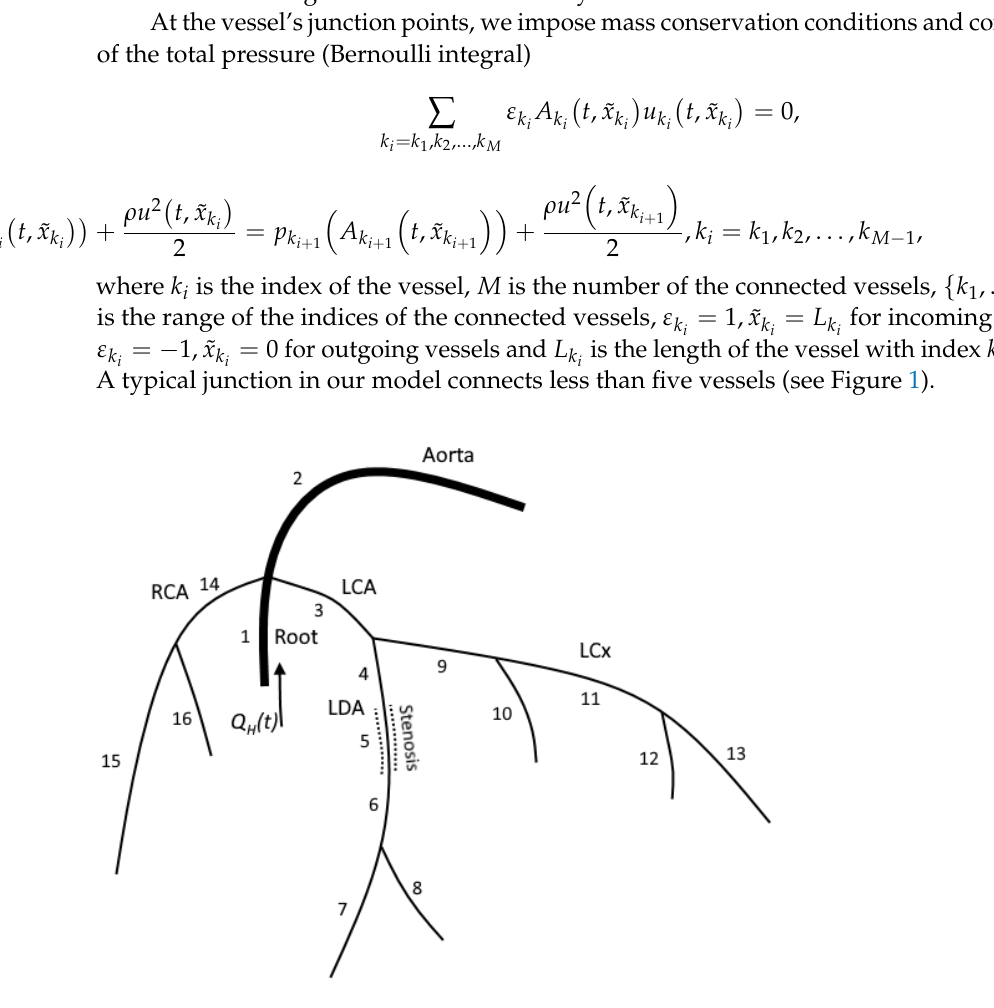
Figure 1. The structure of the computational domain for patient 1. LCA and RCA were extracted from the patient’s CT scans. Each numbered segment corresponds in the model to a one-dimensional tube. Stenosis is a separate segment with decreased diameter. We solve hyperbolic set (1) in the inner points of each segment. We impose mass conservation (5) and continuity of the total pressure (6) on each junction. FFR is measured at segment